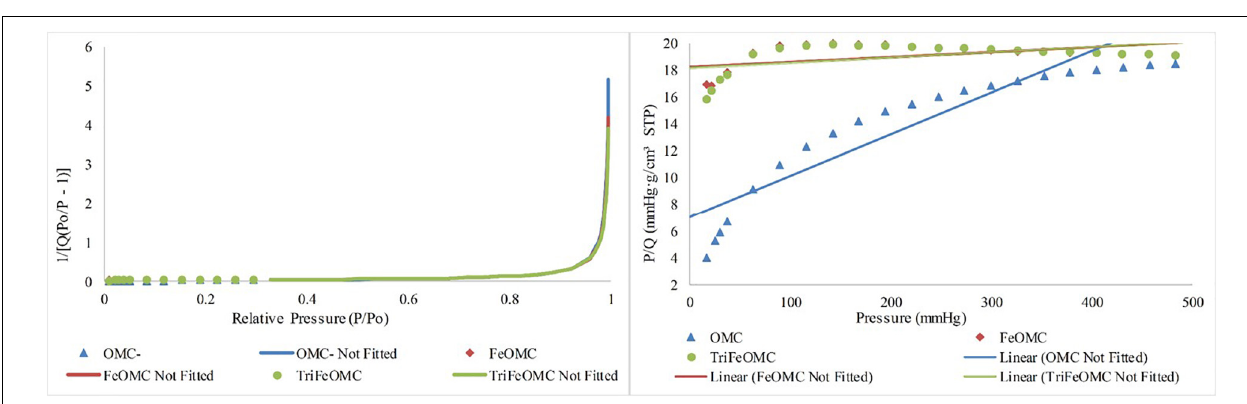
from a total of 0.20 (%/C ◦ ) as shown in Figure 6 . The total size